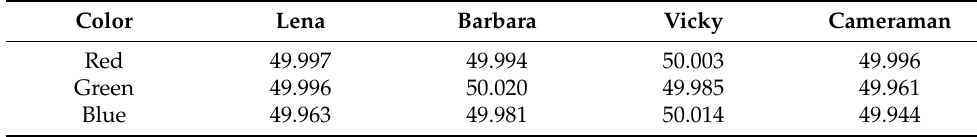
Table 7. AC of the test images after encryption.